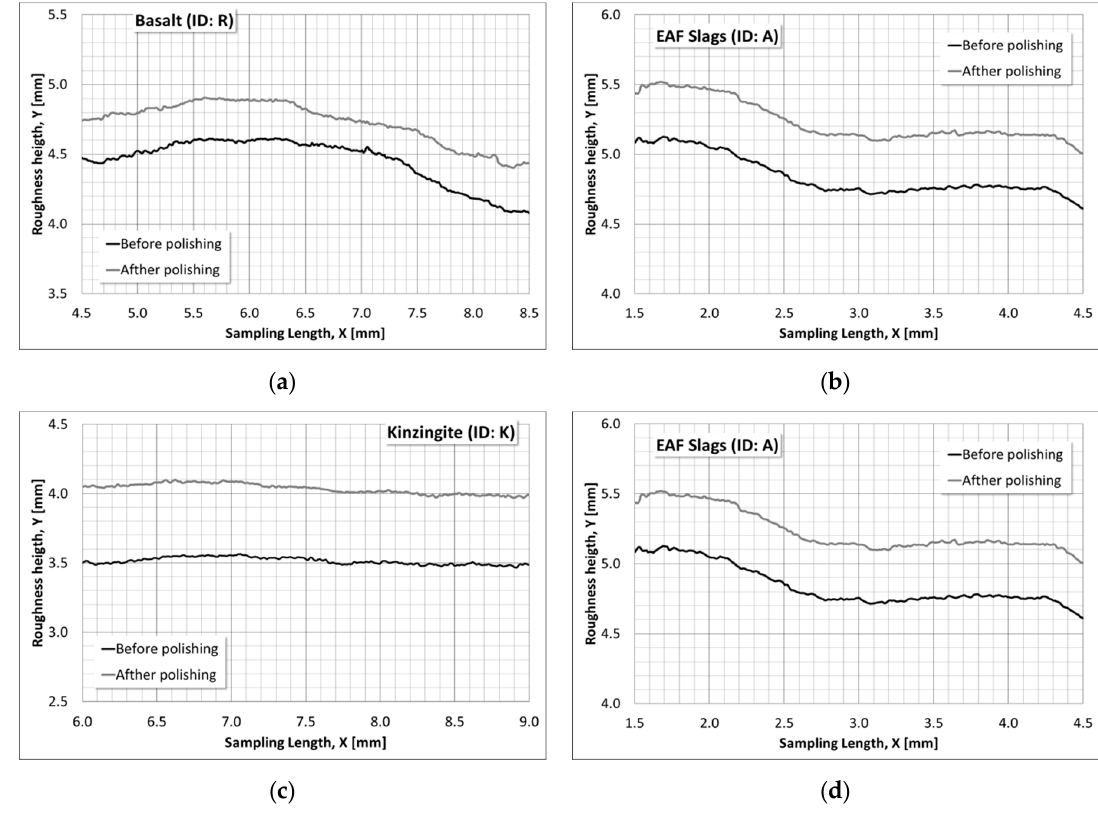
Figure 9. Examples of profile segments from the examined aggregates before and after polishing process: ( a ) basalt; ( b ) EAF Slags; ( c ) kinginzite; ( d ) limestone.